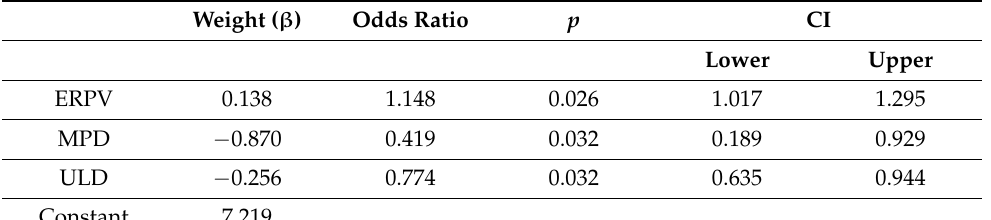
Figure 4. AUC comparison of aFRS and the score in Model 1 for the prediction of CRPF. Model 2 (using ERPV, MPD and UDL).